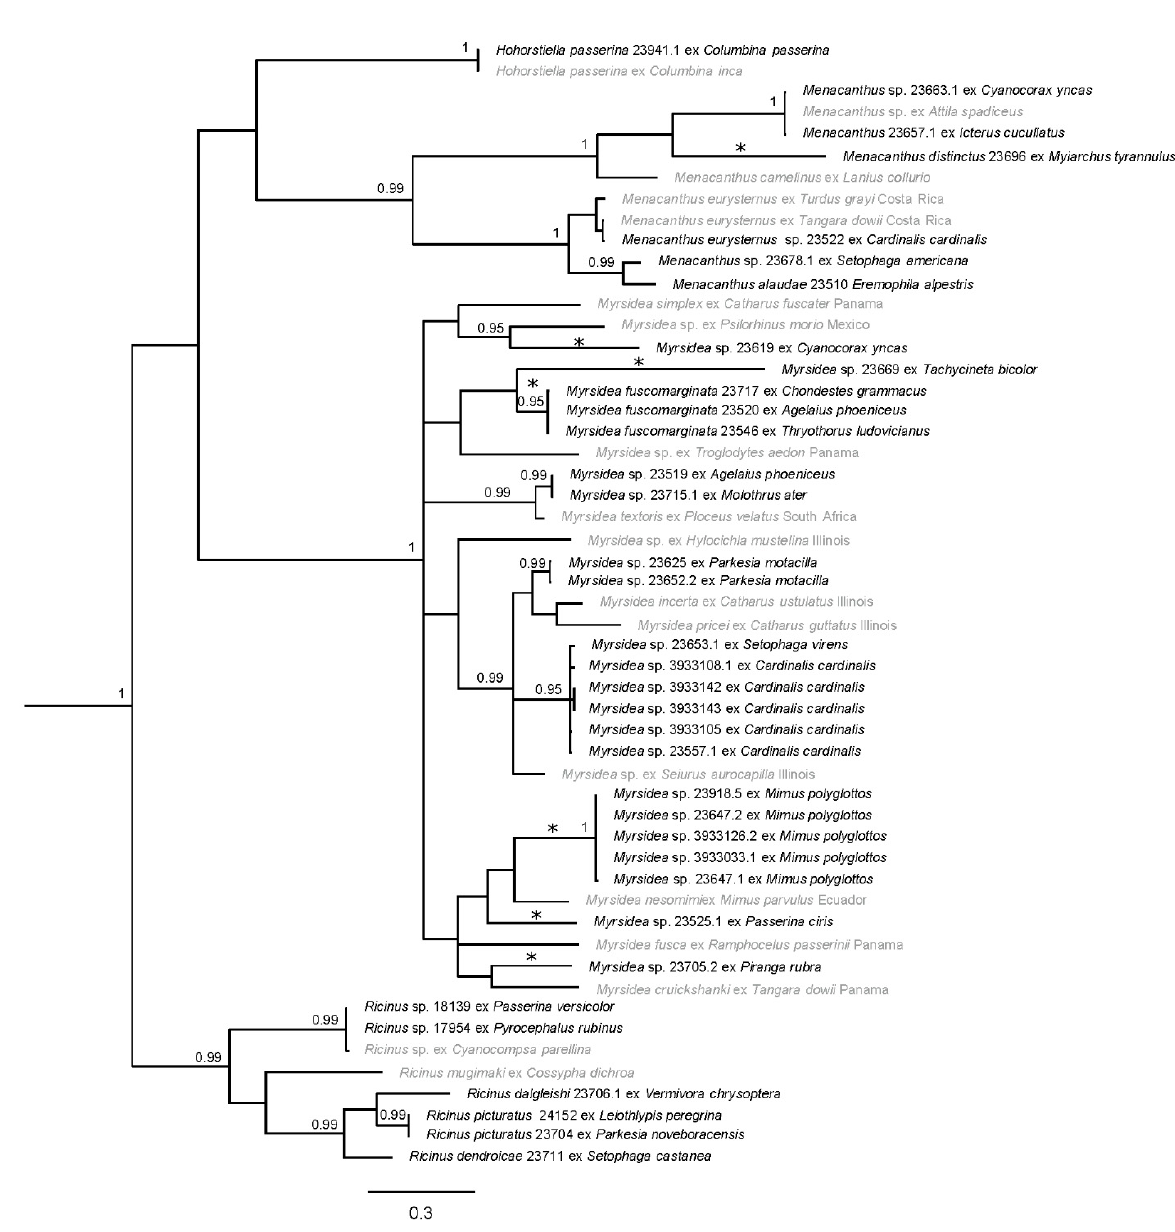
Figure 2. Bayesian phylogram of amblyceran taxa from south Texas. Posterior probabilities ≥ 0.95 are shown and sequences in gray are from GenBank. Distinct genetic lineages are denoted with asterisks (*); one of these lineages ( Menacanthus distinctus ) represents a morphologically described taxon. Taxon labels for newly sequenced specimens include the louse species (if identified), unique identifier (generally matching the host voucher number), and host species. Taxon labels for GenBank specimens include louse species (if known), host species, and sampling location (if known). Outgroup taxa have been pruned.